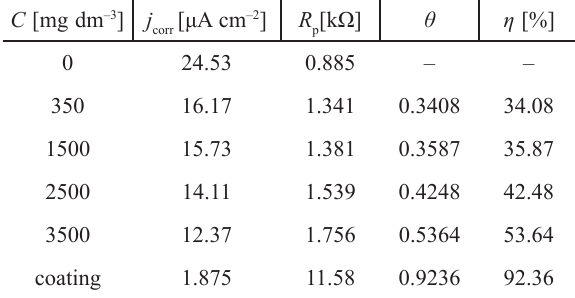
Table 1 – Linear polarization parameters for copper corro- sion in 0.5 M NaCl in the presence of various concentrations of propolis extract at temperature 25 º C